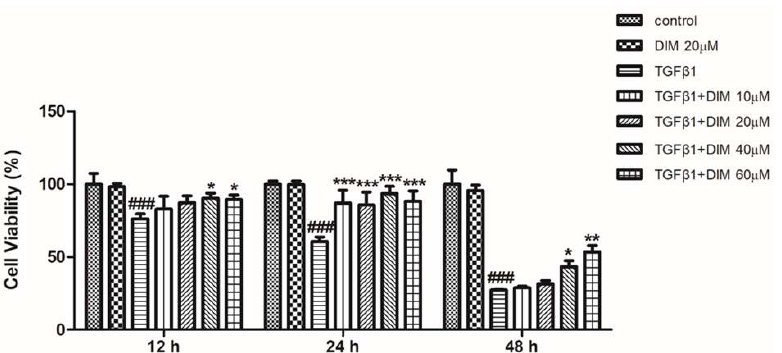
Figure 1. DIM inhibits TGF-β1 induced hepatocytes toxicity: MTT assay reveals that DIM could restore cell viability and reduce TGF-β1 induced cell toxicity of AML12 cells in both time- and concentration-dependent manner as compared with treatment with TGF-β1 only. Data are presented as mean ± SE from three identical experiments. ### , p < 0.001 denotes significant differences compared to the control; *, p < 0.05; **, p < 0.01; and ***, p < 0.001 compared to treatment with TGF-β1 only.